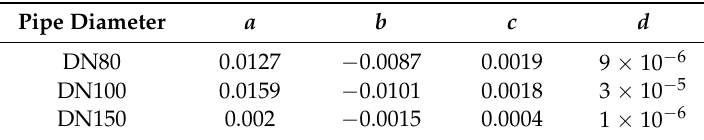
Table 3. Coefficient